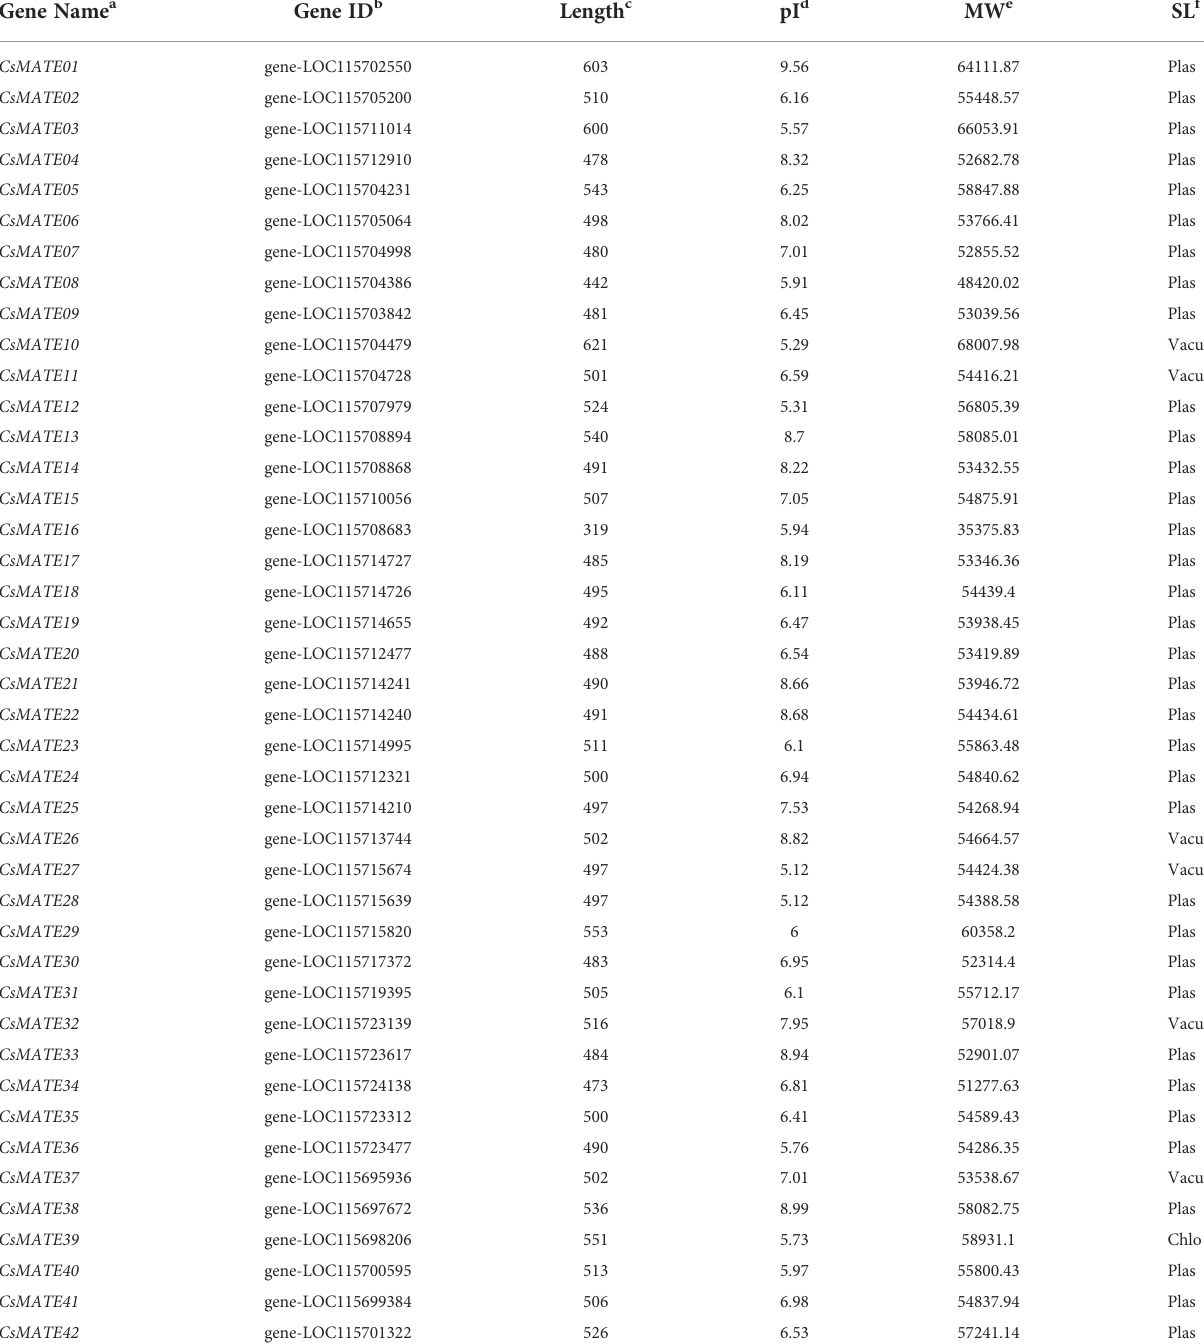
TABLE 1 Detail information of